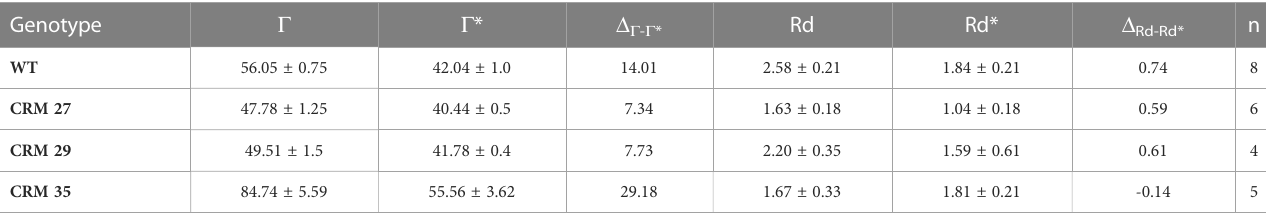
TABLE 4 Corrected CO 2 compensation point and dark respiration in the parental wild type (WT) IR64 compared to select Chlorophyll Retention Mutants (CRMs). Genotype